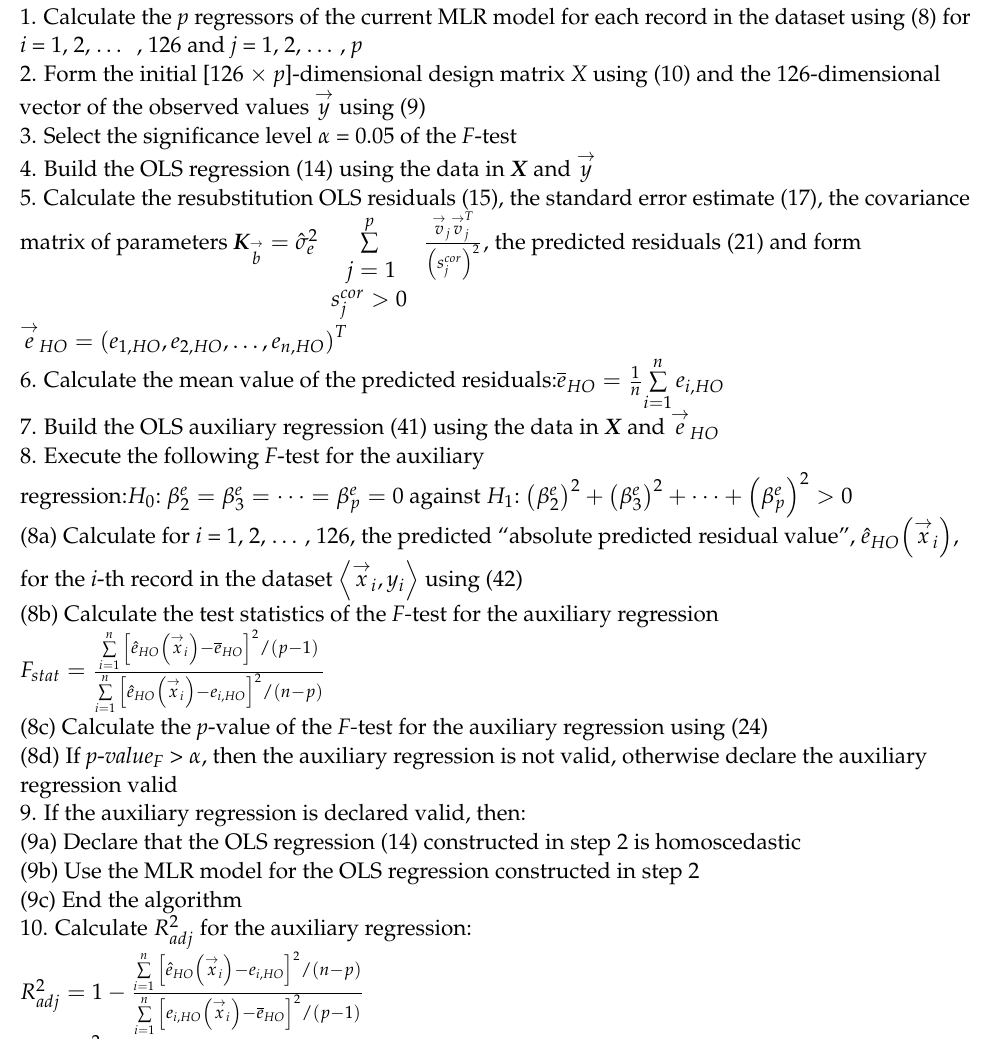
Algorithm 3: Modified heteroskedasticity testing and relaxing algorithm (MHTRA) for the MLR